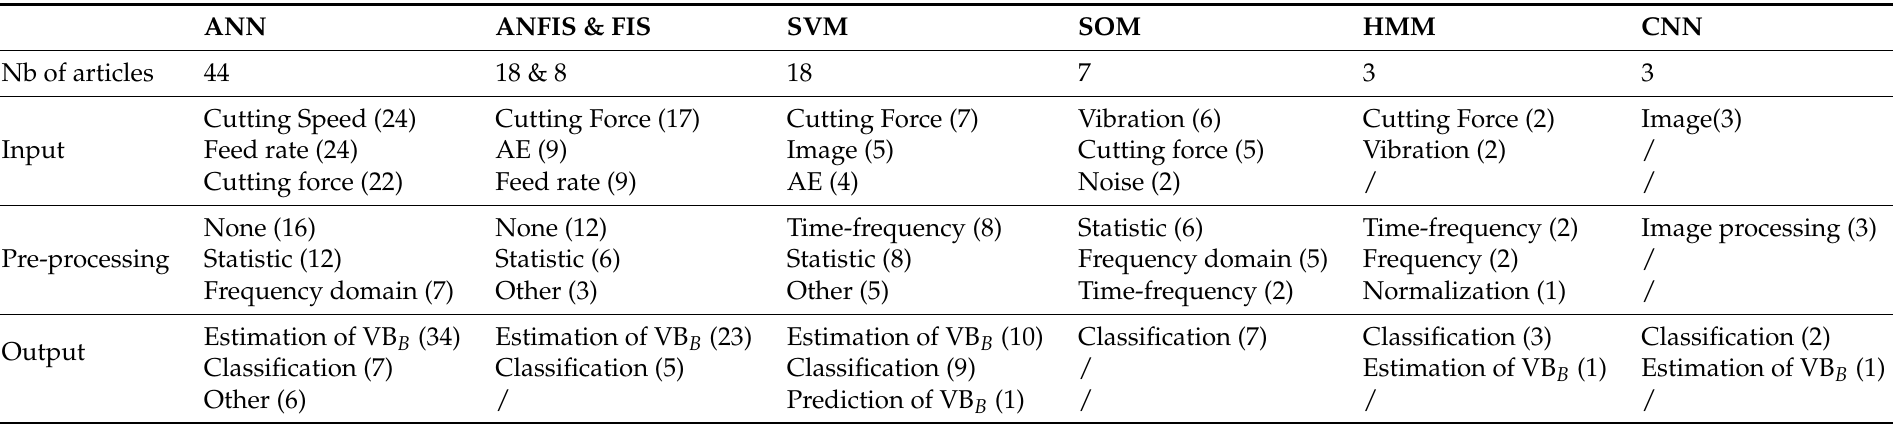
Table 3. Comparison of the three most used: input, pre-processing and output for each